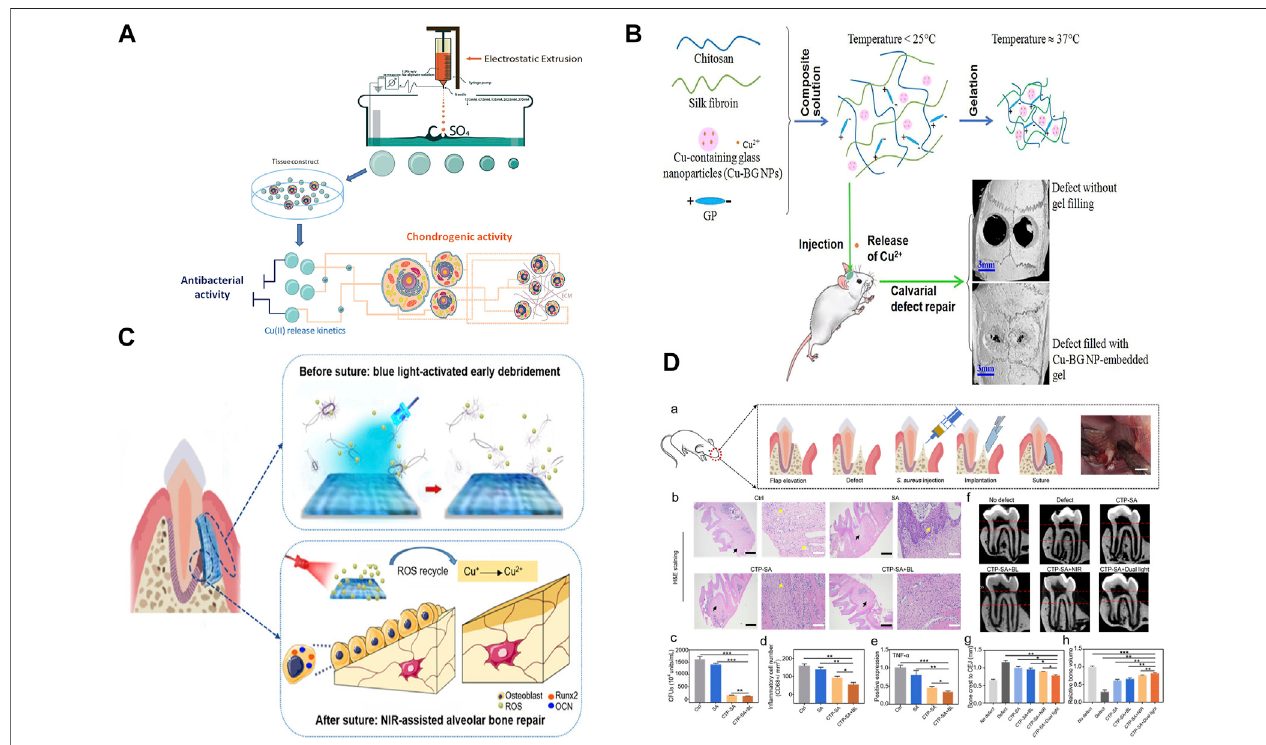
FIGURE3|(A) Synthesisandpotentialbiomedicalapplicationsofcopperalginatemicrospheres. (B) Developmentofanovelinjectablehydrogelanditsosteogenic application. (C) SchematicdiagramofsurgicalconstructionofCTP-SAandGTR. (D) Invivo functionofCTP-SAinGTRsurgery.Panel (A) reprintedwithpermissionfrom ref. (Madzovska-Malagurski et al., 2016) (Copyright 2016; IOP Publishing Ltd.). Panel (B) reprinted with permission from ref. (Bassett et al., 2014) (Copyright 2019; Elsevier). Panel (C) and panel (D) reprinted with permission from ref. (Xu et al., 2020) (Copyright 2020; American Chemical Society).